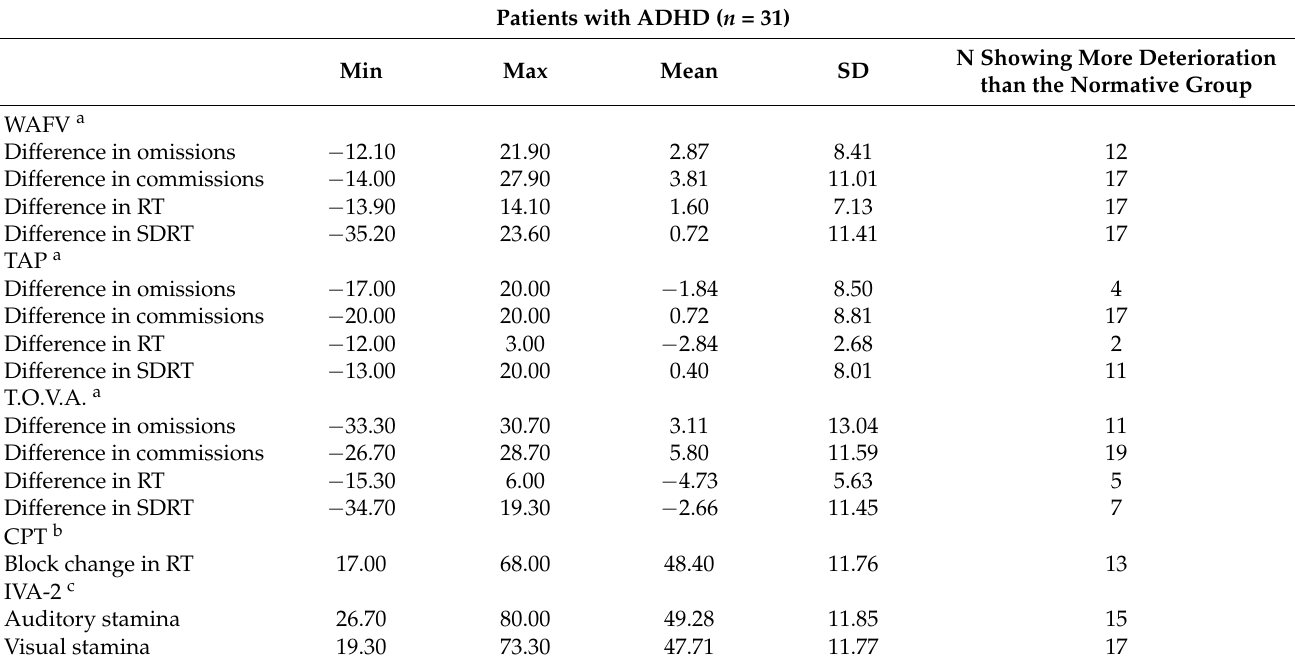
Table 4. T -scores and T -scores differences indicating time-on-task